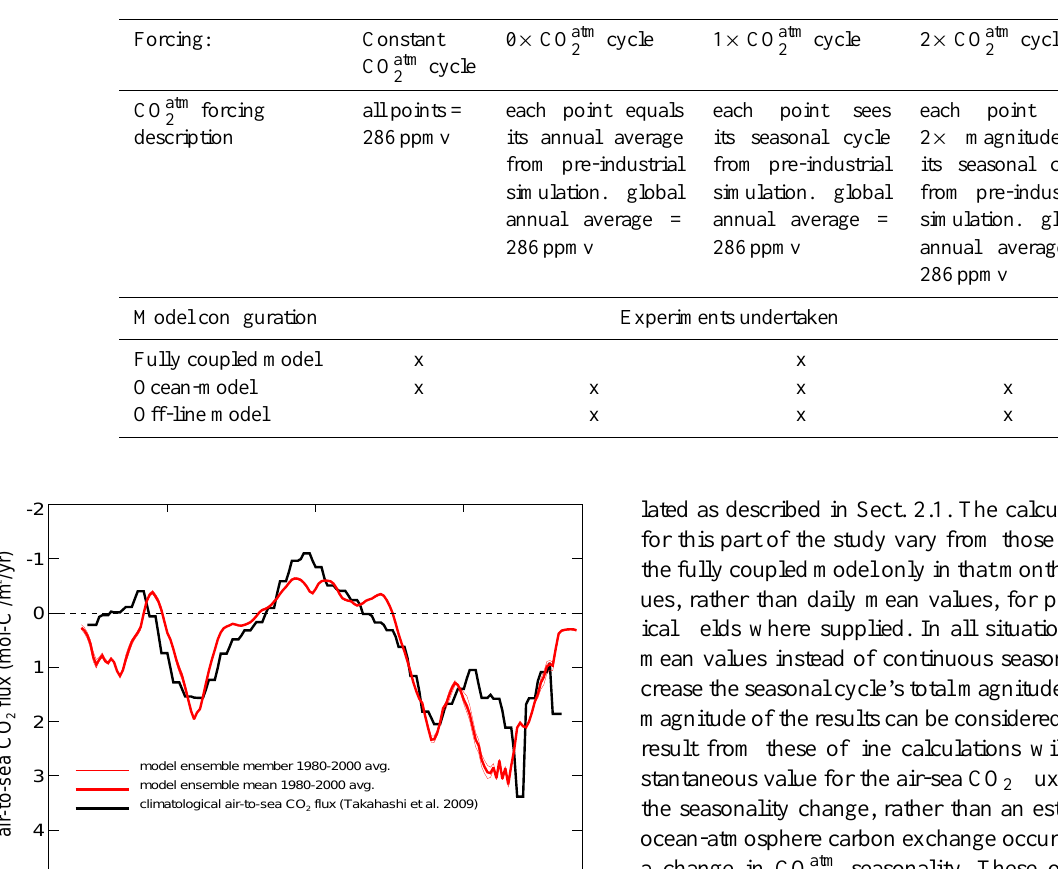
seasonal cycle forcing) 2